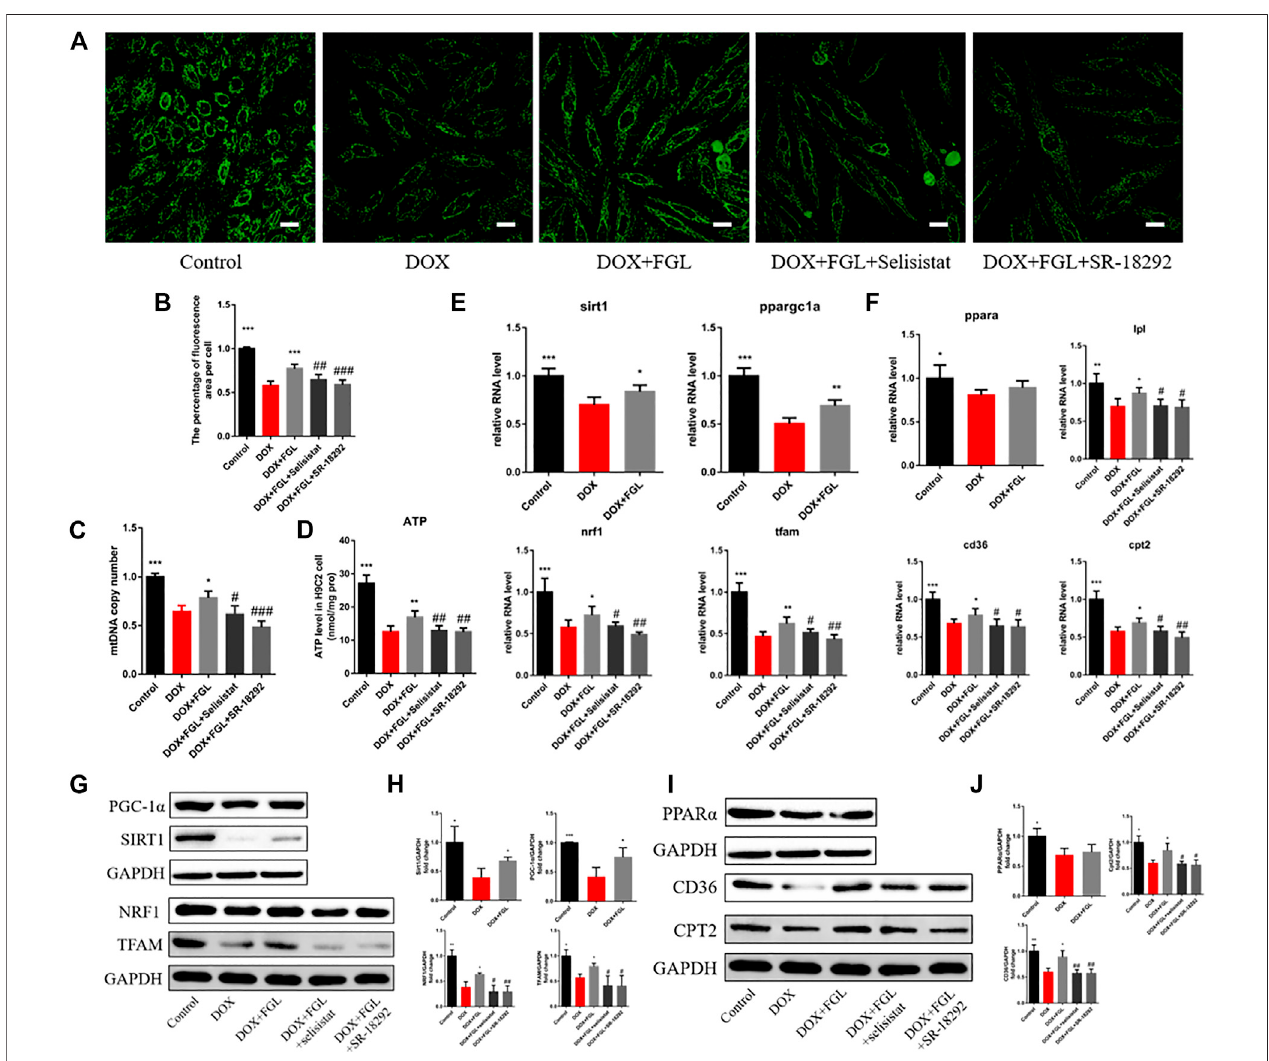
FIGURE 5 | FGL promoted mitochondrial biogenesis and fatty acid oxidization in vitro . (A, B) Representative images and quantitative analysis of the number of mitochondria bymitotracker stainingin H9C2 cells(n (cid:2) 6). Scale bar:25 μ m. (C) TheassessmentofthemtDNA copy number inH9C2 cells byRT-qPCR (n (cid:2) 4). (D) The content of ATP in H9C2 cells (n (cid:2) 5). (E, F) The expression level of mitochondrial biogenesis and fatty acid oxidization-associated mRNA in H9C2 cells quanti fi ed and shown as relative RNA levels after normalization to GAPDH (n (cid:2) 5). (G – J) The expression level of mitochondrial biogenesis and fatty acid oxidization-associated proteinsinH9C2cellsquanti fi edandshownasrelativeproteinexpressionlevelsafternormalizationtoGAPDH(n (cid:2) 3 – 5).* p < 0.05,** p < 0.01,*** p < 0.001vsDOXgroup. # p < 0.05, ## p < 0.01, ### p < 0.001 vs. (DOX + FGL)